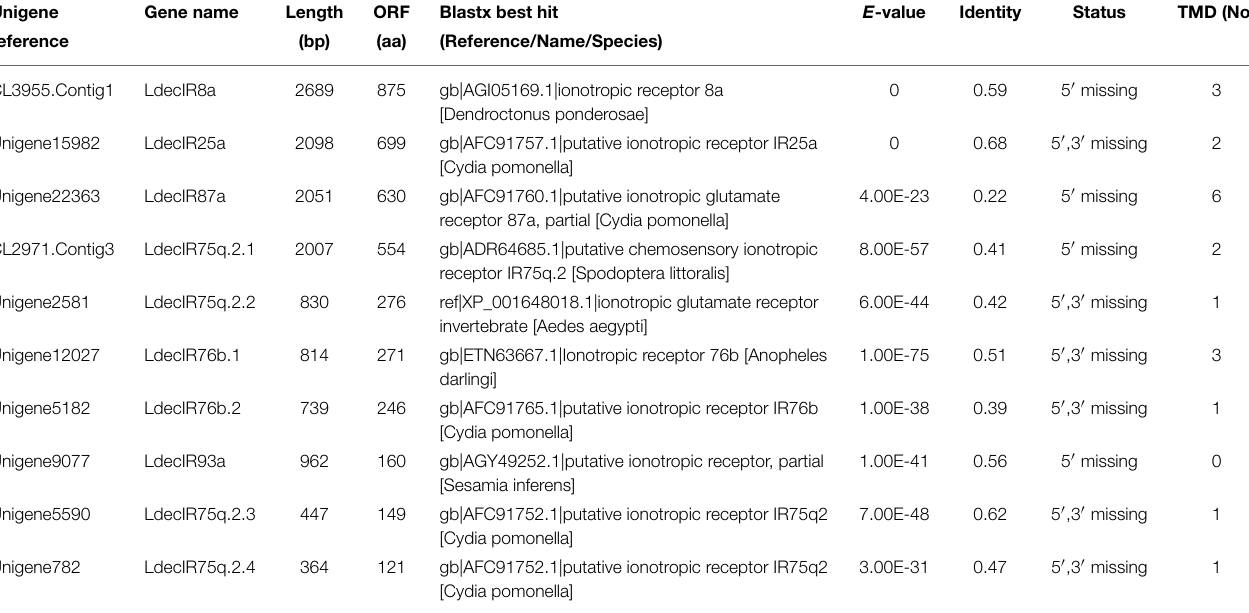
TABLE 6 | Unigenes of candidate ionotropic